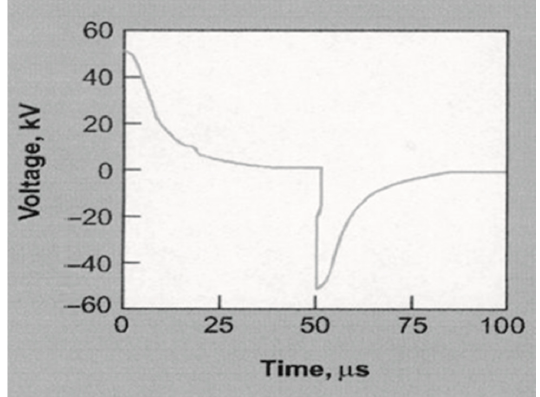
Figure 5. The assumed shape of a bipolar “exponential” pulse [32].